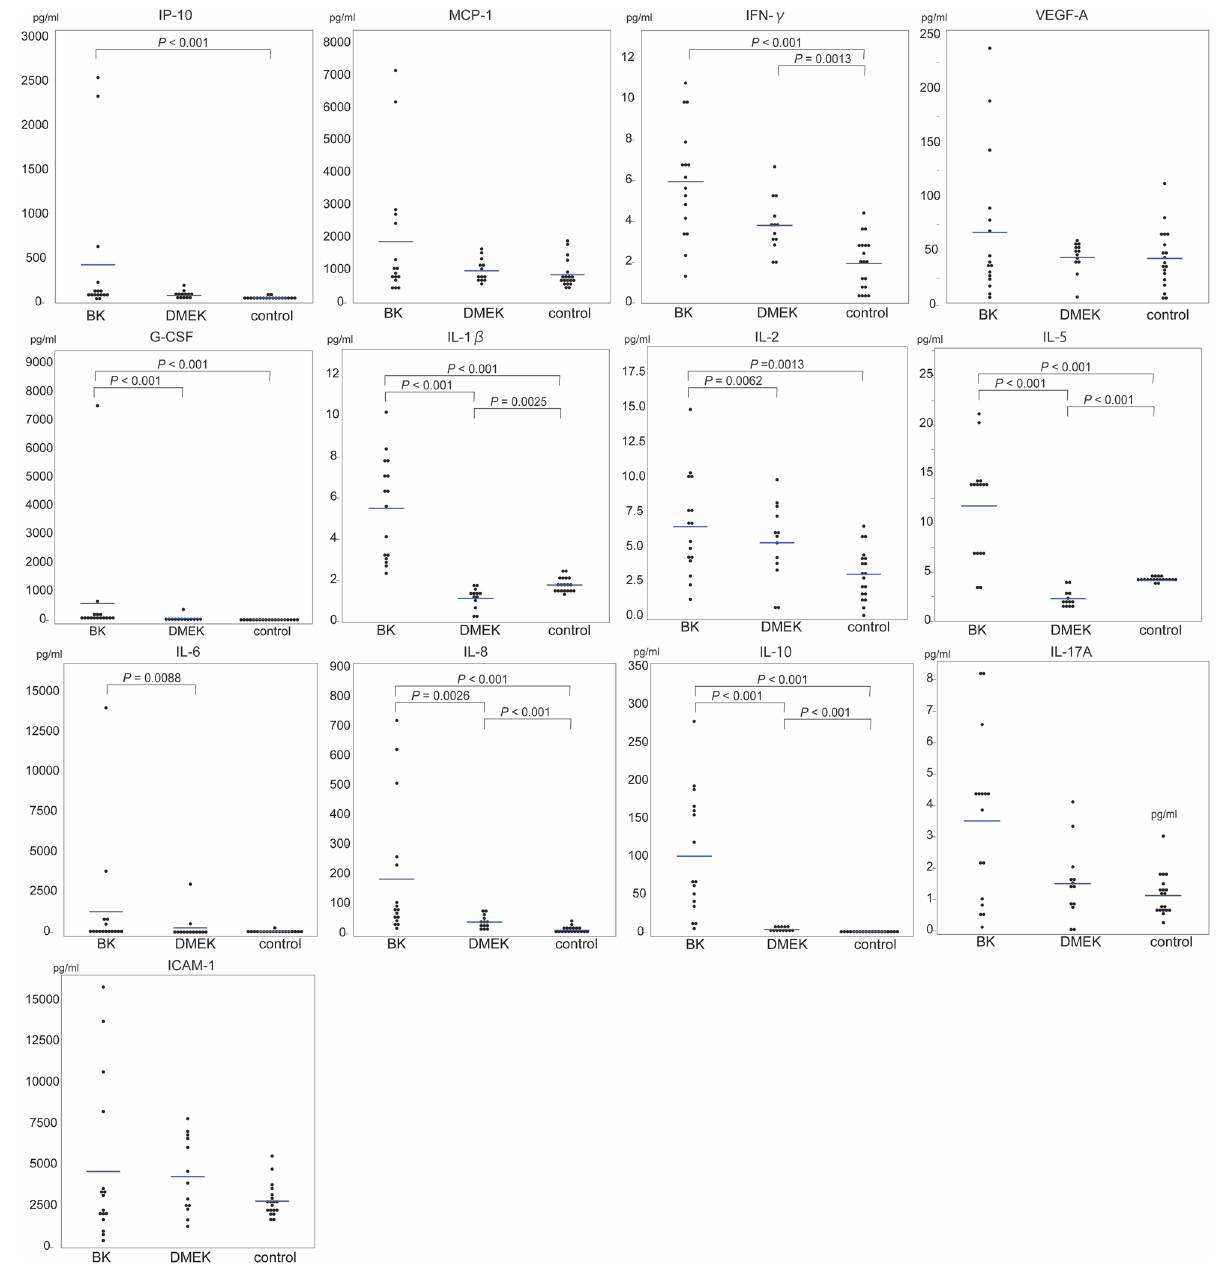
factor-a [VEGF-A], granulocyte colony stimulating factor [G-CSF], interleukin [IL]-1β, IL-2, IL-5, IL-6, IL-8, IL-10, IL-17A, and the intercellular adhesion molecule [ICAM-1] in AqH were measured using a multiplex bead immunoassay, and compared among BK, DMEK, and control groups. Cytokine concentrations were logarithmically transformed and analysed using Tukey’s test. Note the different scaling of the